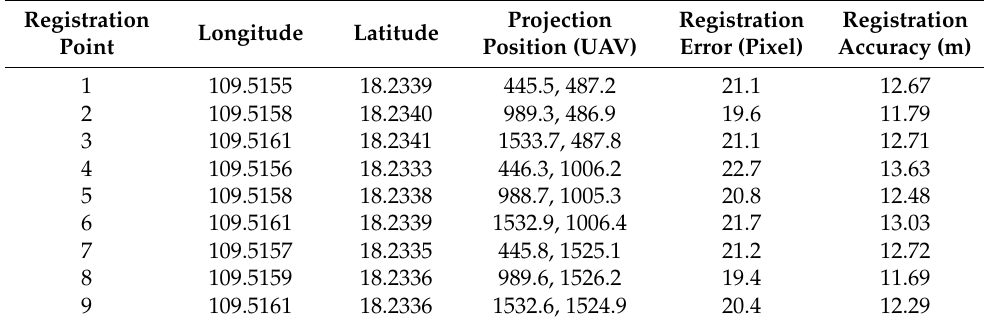
Table 5. Experimental results of heterogenous image